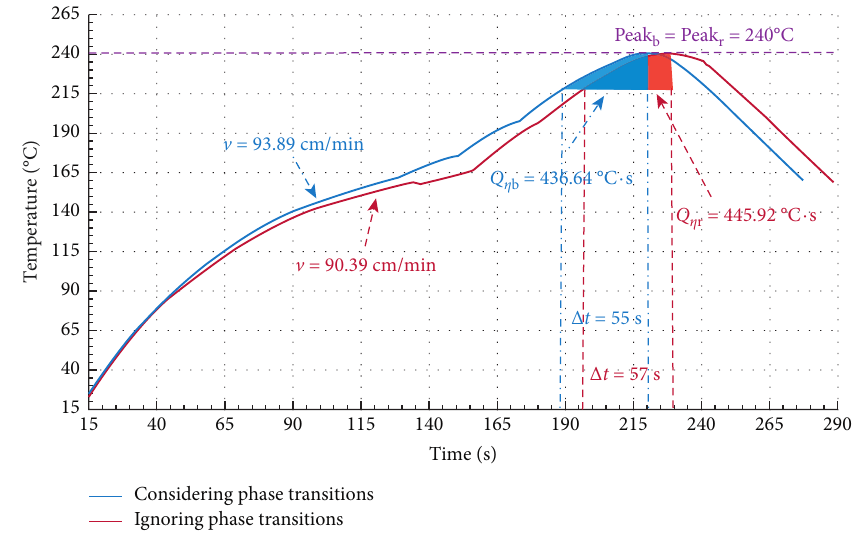
Figure 8: The optimal temperature profiles in the two cases, considering and ignoring phase